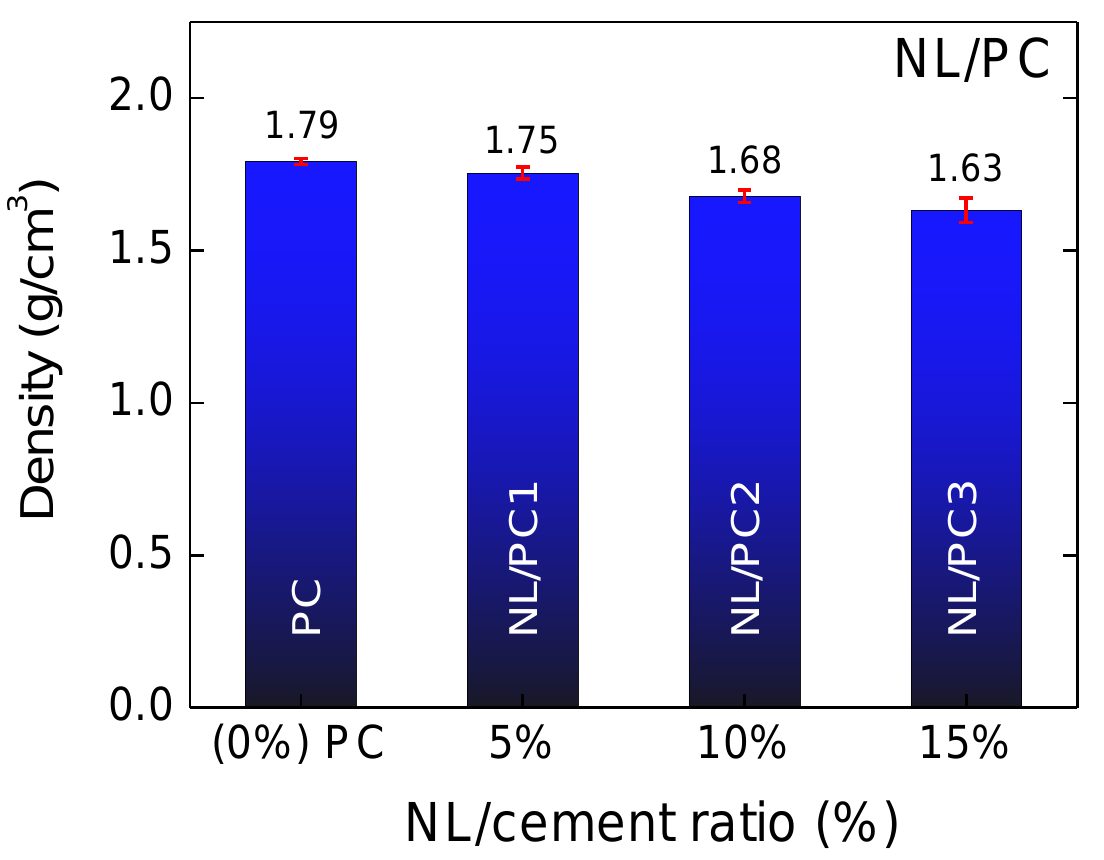
Figure 1. Bulk densities of the control PC and NL/PC1, NL/PC2, and NL/PC3 composites with NL/cement ratios of 5%, 10%, and 15%, respectively.